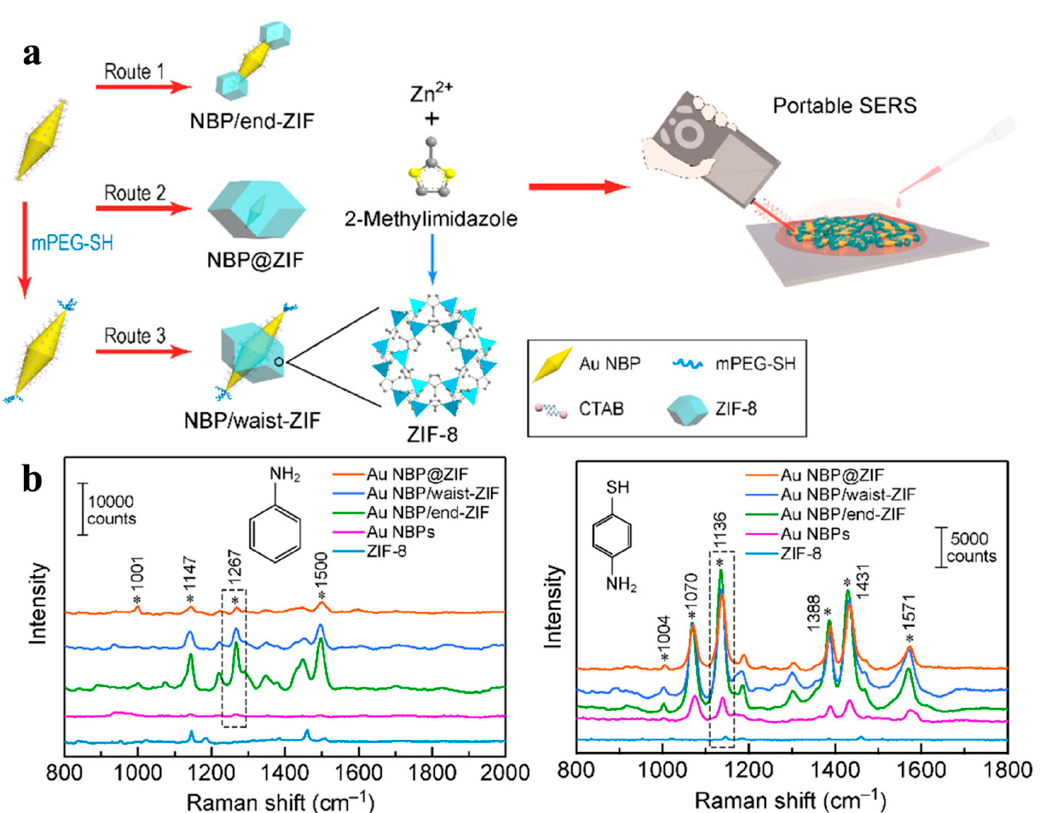
Figure 8. SERS of NBP@ZIF. ( a ) Schematics showing the routes for selective deposition of ZIF-8 on the Au NBPs and SERS detection. ( b ) SERS spectra measured with the ZIF-8 nanocrystals, Au NBPs, NBP/end-ZIF, NBP/waist-ZIF, and NBP@ZIF nanostructures for the detection of aniline and 4-ATP, respectively [71]. Copyright 2021, American Chemical Society.